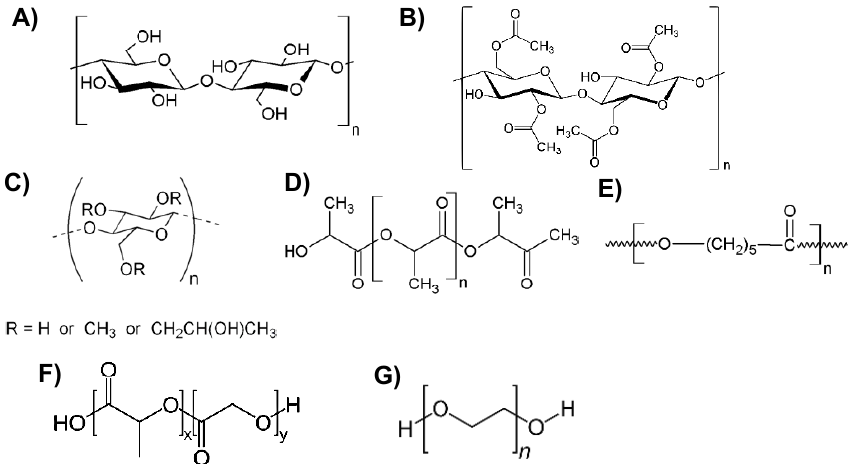
Figure 1. Chemical structures of cellulose ( A ), cellulose acetate ( B ), hydroxypropyl methylcellulose ( C ), polylactic acid ( D ), polycaprolactone ( E ), poly(lactic-co-glycolic) acid ( F ), polyethylene glycol (PEG) ( G ).